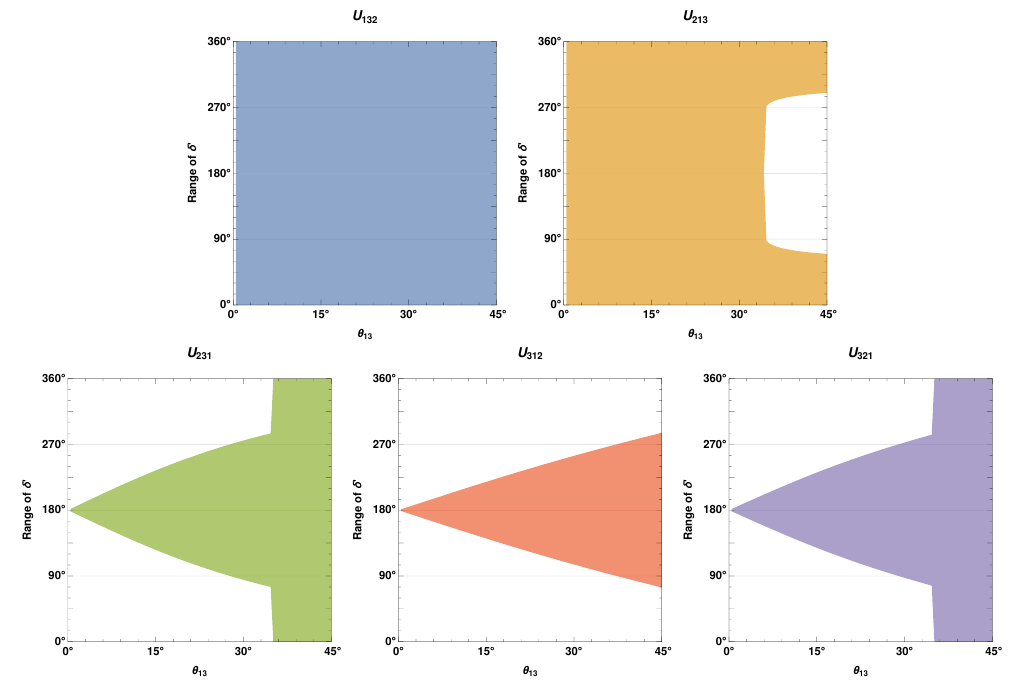
Figure 4 . The allowed range of δ 0 in different parameterizations as a function of θ 13 in the PDG parameterization. We have fixed the other mixing angles to their best fit values while δ is